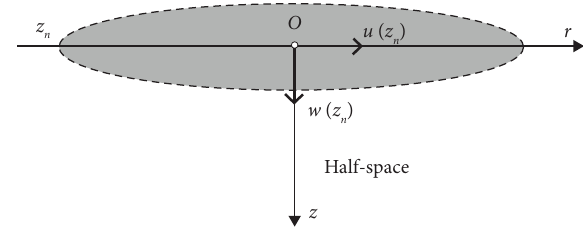
Figure 3: Te homogeneous half-space